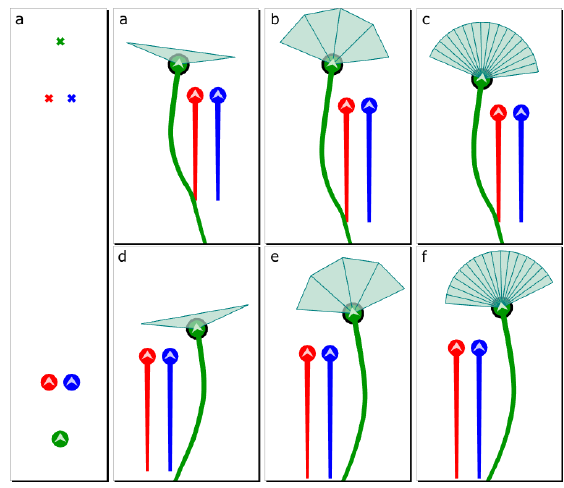
Figure 7. In the first column (a), the initial configuration: two agents (red and blue) walk in parallel, while a third agent (green) wants to move through them with a greater speed. The X mark shows the goals of the agents. By testing different number of slices (1, 4 and 16 from left to right), there are almost no changes in the behavior of the agent. (b), (c) and (d) were using OSV, whereas (e), (f) and (g) were using GBM.